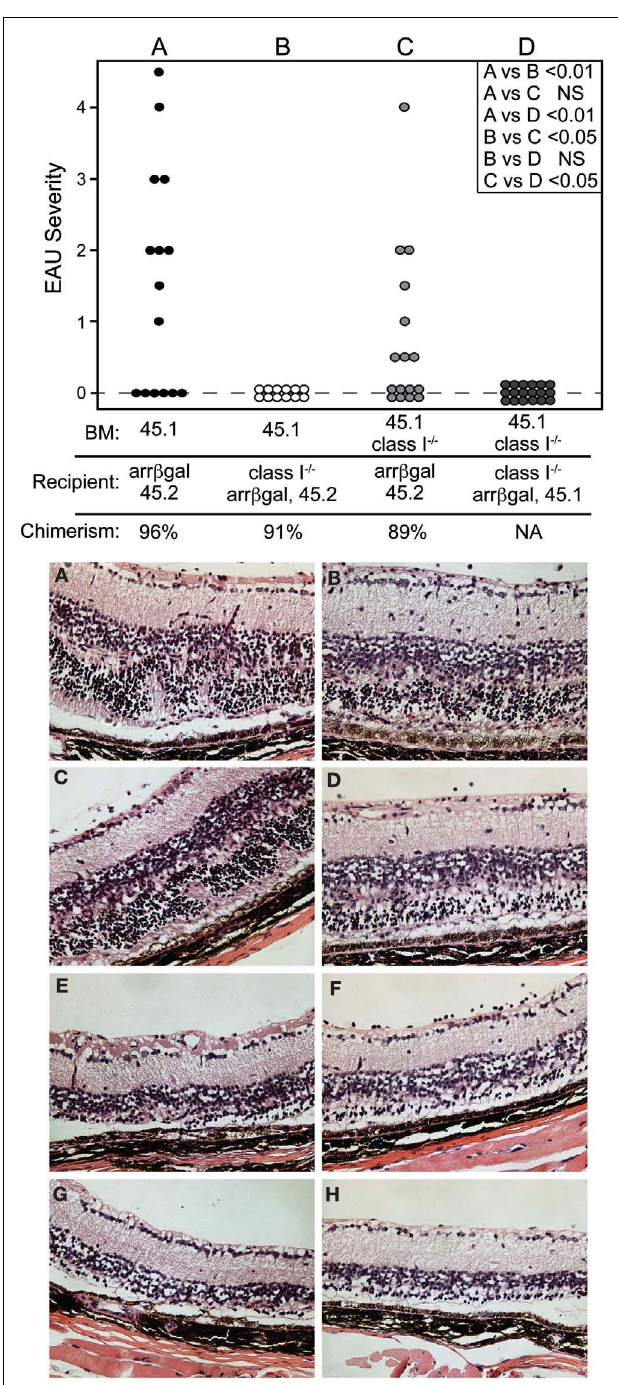
FIGURE 7 | Local expression of MHC class I is sufficient to support pathogenesis of CD8T cell mediated EAU. TOP. Chimeric mice made in recipients that were MHC class I + , but whose non-resident retinal immune cells were replaced by grafting class I - BM (group C) were susceptible to EAU by adoptive transfer of activated BG1T cells. Conversely, recipient mice that were class I − , but given class I + BM (group B) were resistant to EAU. Control groups A and D were subjected to the chimerism procedures, but were fully class I + or class I − , respectively. Recipients were